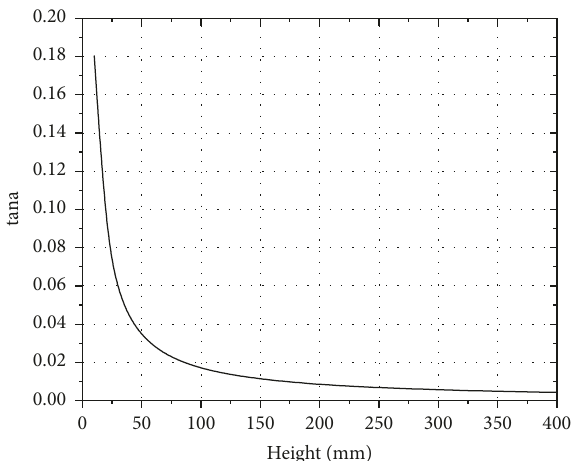
Figure 5: Relationship between leveling angle and height of paste.